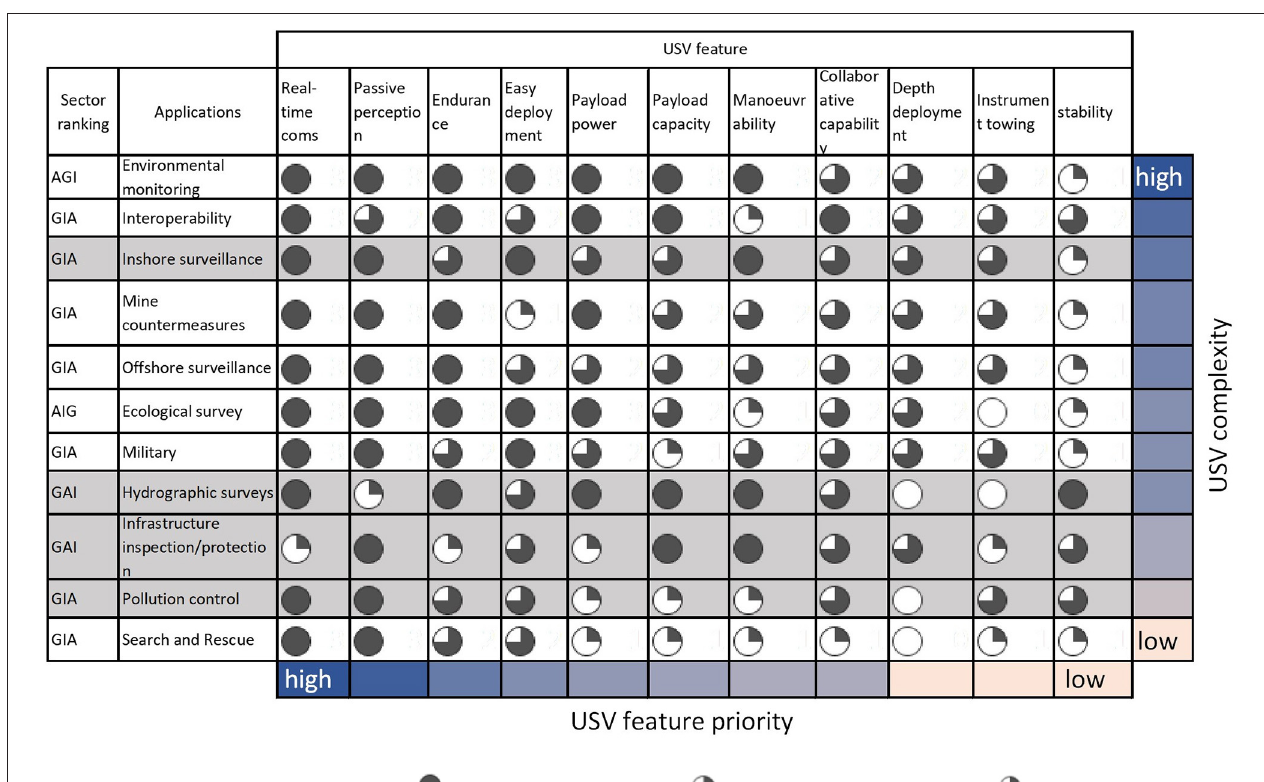
FIGURE 4 | USV features are ranked using symbols: essential for application success, highly enhances application success, beneficial to application, application does not benefit from this feature. Columns and rows depict feature importance (column) to the application (row). Total USV complexity and feature priority are ranked from blue (high) to beige (low). Grey and white rows are ES and UU archetype applications, respectively. Sector ranking is described in the Quantitative Data Analysis section of the